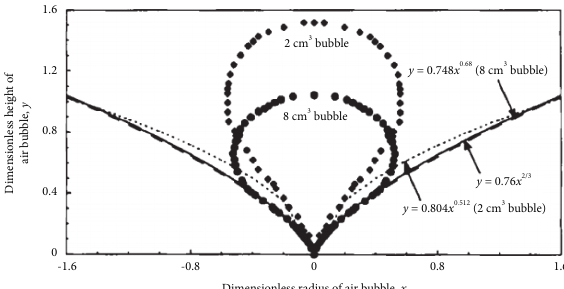
Figure 6: Analytical approximations of the cusp shape for a 2cm 3 and 8 cm 3 bubble [30].